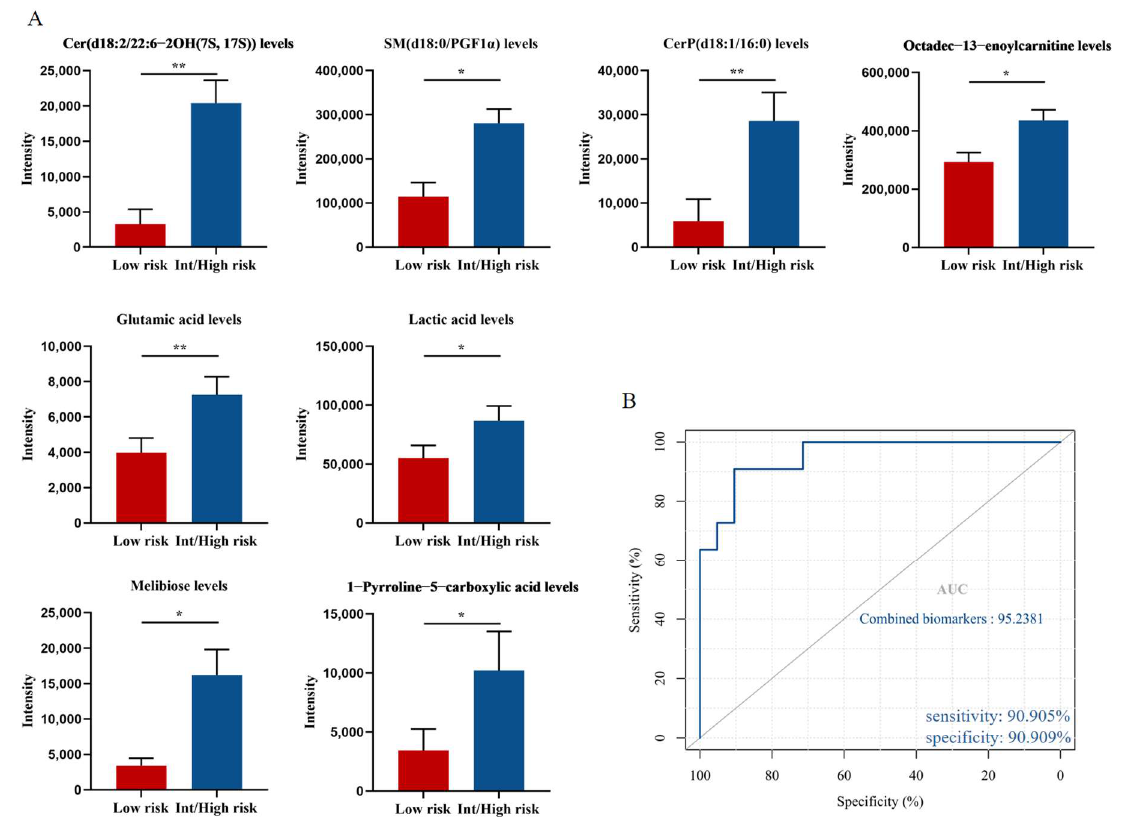
Figure 7. Potential biomarkers related to the prognosis of PV patients. ( A ) Levels of Cer(d18:2/22:6- 2OH(7S, 17S)), SM(d18:0/PGF1 α ), CerP(d18:1/16:0), octadec-13-enoylcarnitine, glutamic acid, lactic acid, melibiose and 1-pyrroline-5-carboxylic acid in intermediate/high-risk patients compared with low-risk patients. Mean value ± SEM. Mann–Whitney U test, * p < 0.05, ** p < 0.01. ( B ) ROC curve analysis for the combination of 4 biomarkers.